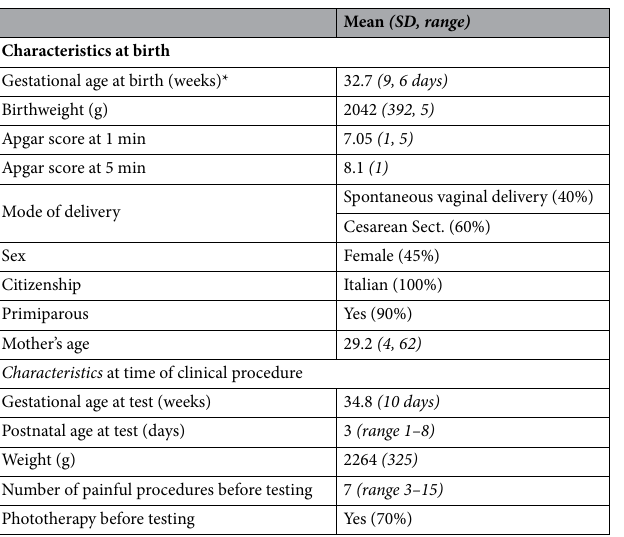
Table 1. Infant demographics. *Postmenstrual age should be used for clarity in neonatal practice. In our unit, the infants’ age is recorded in the medical and nursing notes as gestational age, and we have used this